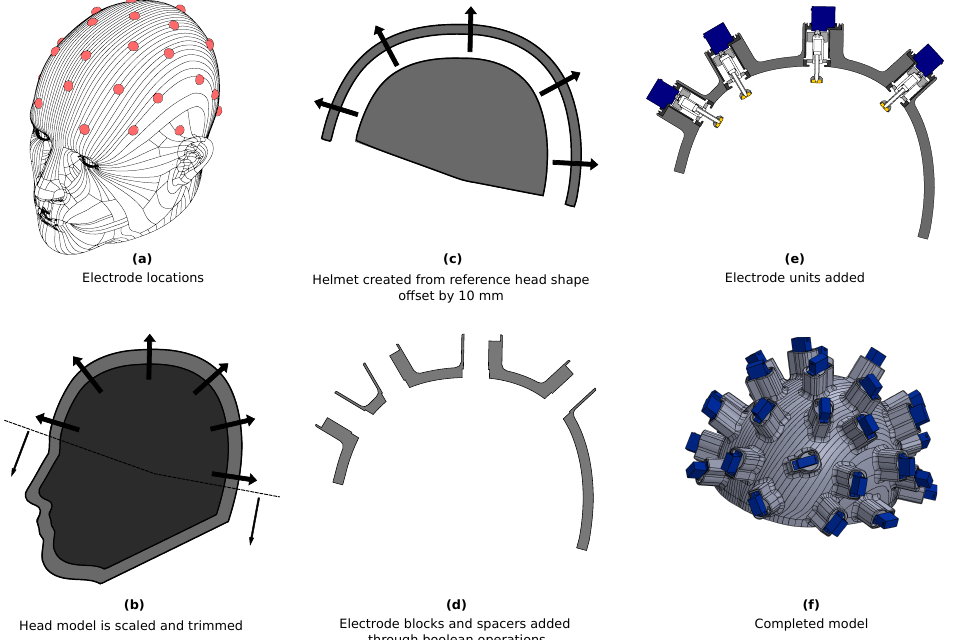
Figure 13. Design of electrode bearing helmet ( a ) 32 electrode locations ( b ) the scalp model is scaled to match the nominal head dimensions [44] and model trimmed below in inion-nasion line, ( c ) helmet frame constructed from 10 mm offset of nominal scalp surface, ( d ) electrode blocks are added to model and spacers then removed to create housings for each electrode unit aligned to the electrode positions, ( e ) electrode units added to complete model ( f ) final helmet